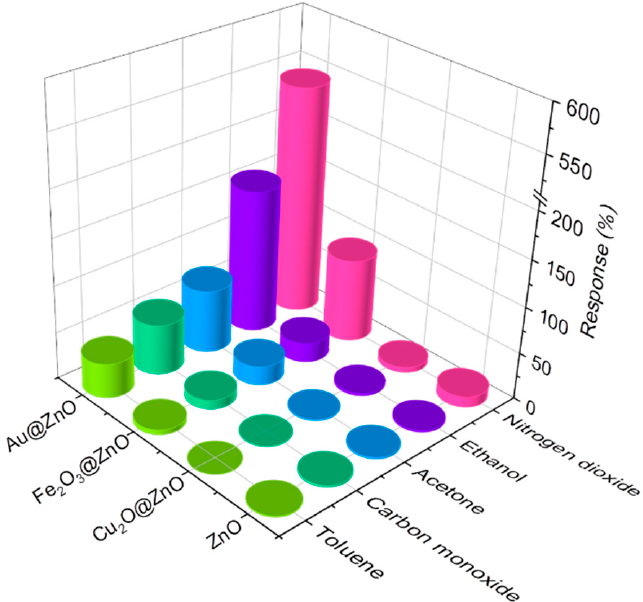
Figure 10. Responses towards 10 ppm of nitrogen dioxide and 80 ppm of ethanol, acetone, carbon monoxide, and toluene for the ZnO, Au@ZnO, Fe 2 O 3 @ZnO, and Cu 2 O@ZnO sensors.